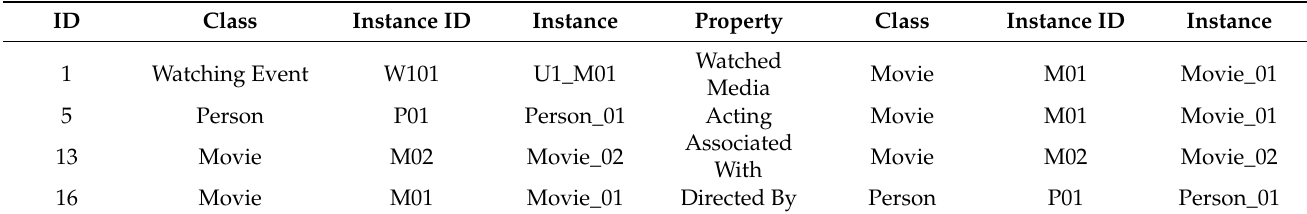
Table 2. Instance graph data structure.